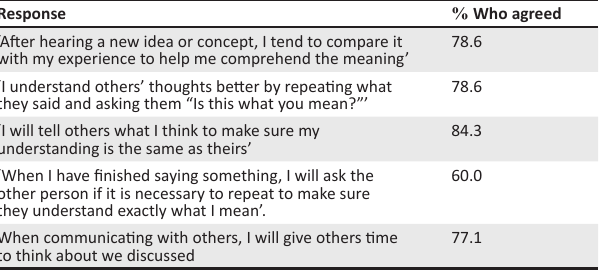
TABLE 3: Use of internalisation .